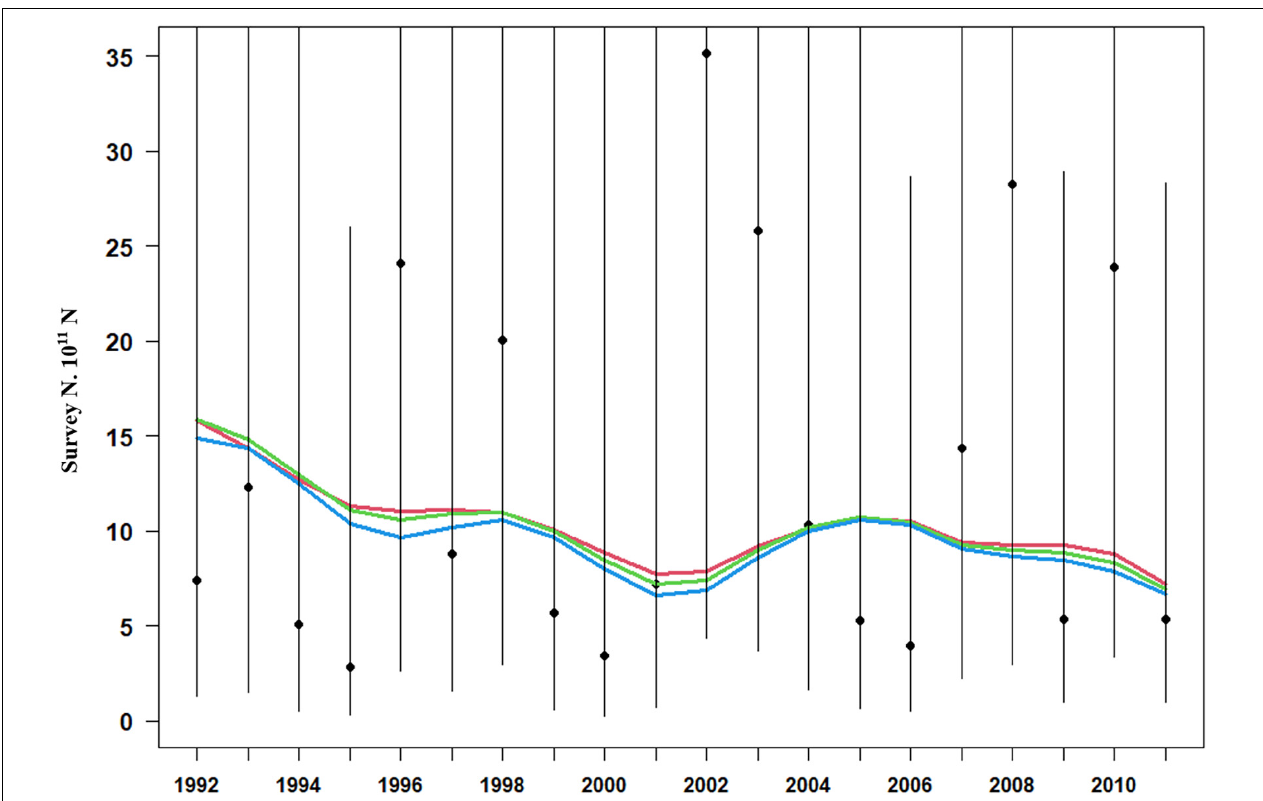
FIGURE 2 | Model fits (three solid line, red line present weights in 0.25, green line present weight in 0.5, blue line present weight in 1) to observed survey number (black dots) with 95% confidence intervals (black lines).